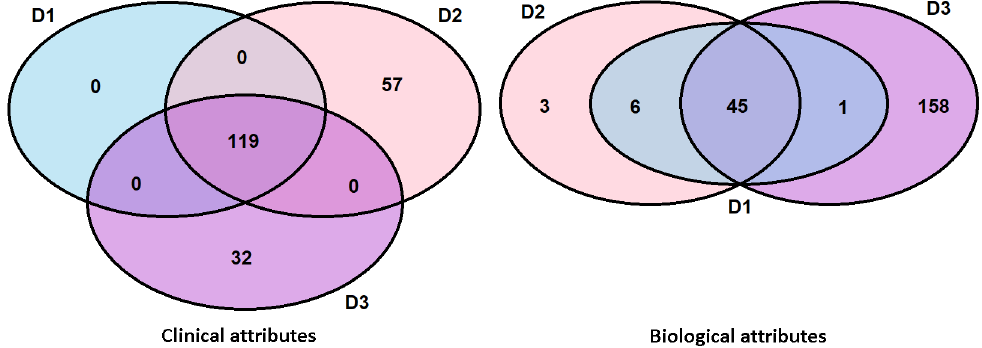
Fig 1. Relations between attributes used in constructed datasets D 1 , D 2 and D 3 . Left Venn diagramdepicts clinicaland right Venn diagram biologicalattributes.